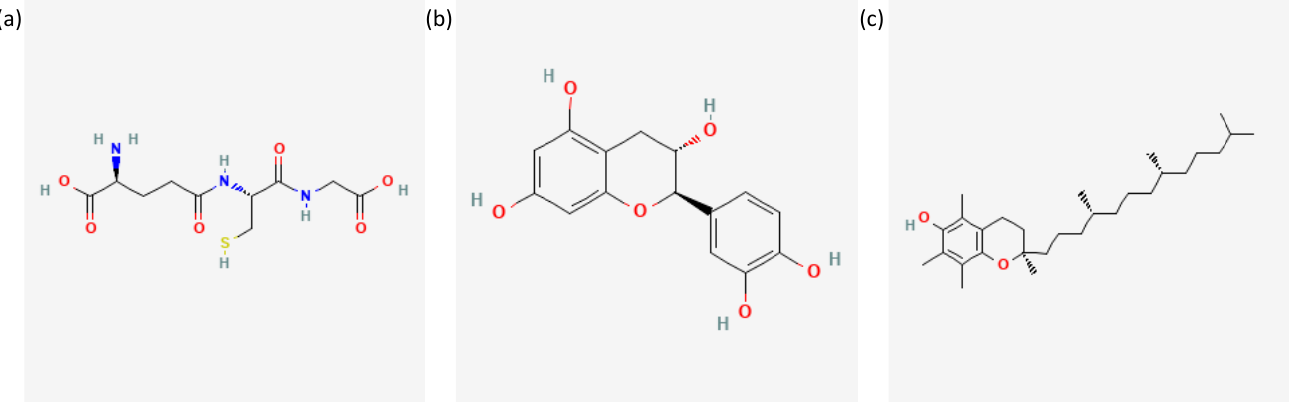
Figure 2. Antioxidant scavenger molecules: ( a ) glutathione [33], ( b ) catechin [34], ( c ) vitamin E [35]. Chemical structures are retrieved from the database PubChem (https://pubchem.ncbi.nlm.nih.gov/; accessed on 21 January 2023).